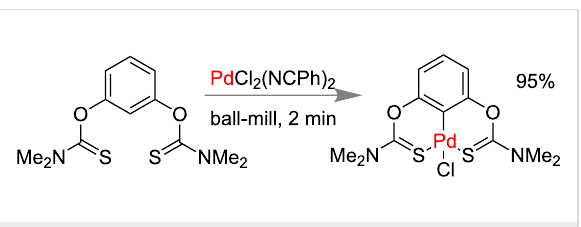
Scheme 47: Mechanochemical synthesis of organometallic pincer complex [179].